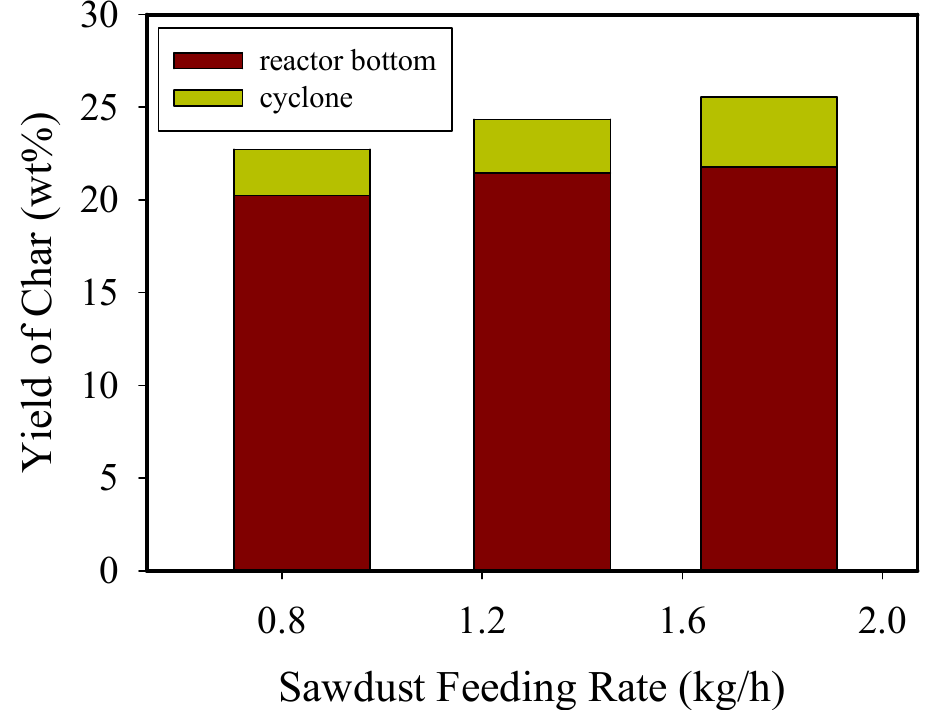
Figure 5. Distribution of char product at different sawdust feeding rate (0.8 kg/h feeding rate, 15 L/min N 2 carrier gas flow rate).